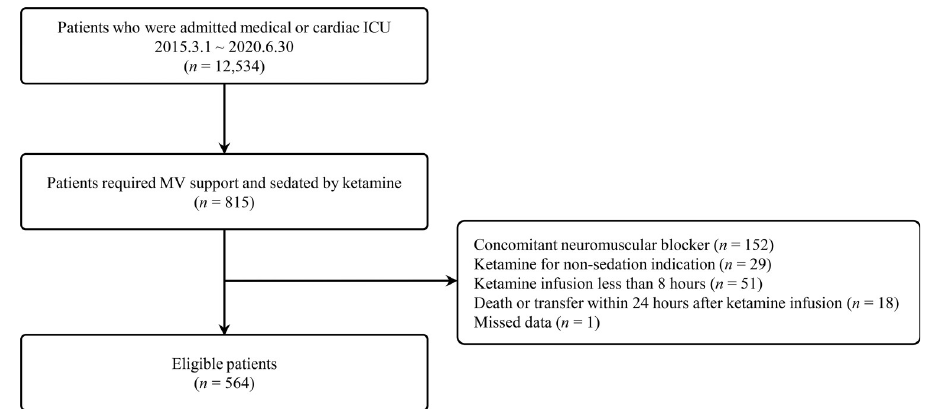
Fig 1. Flow diagram. ICU, intensive care unit; MV, mechanical